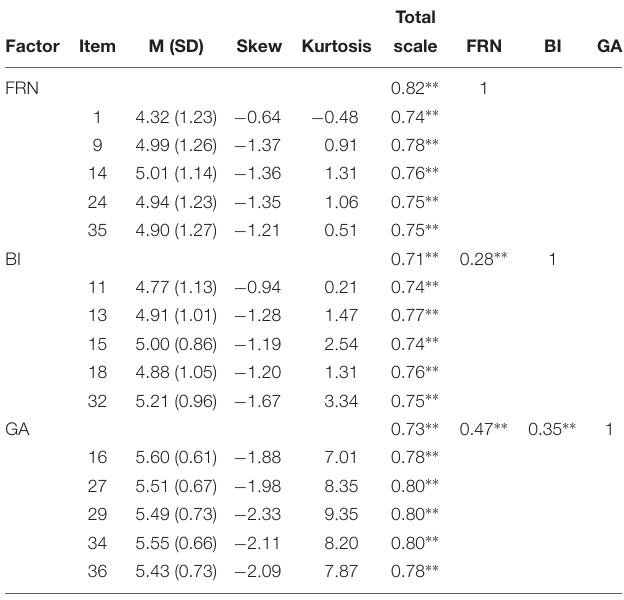
( Table 5 ). Different values between the metric and